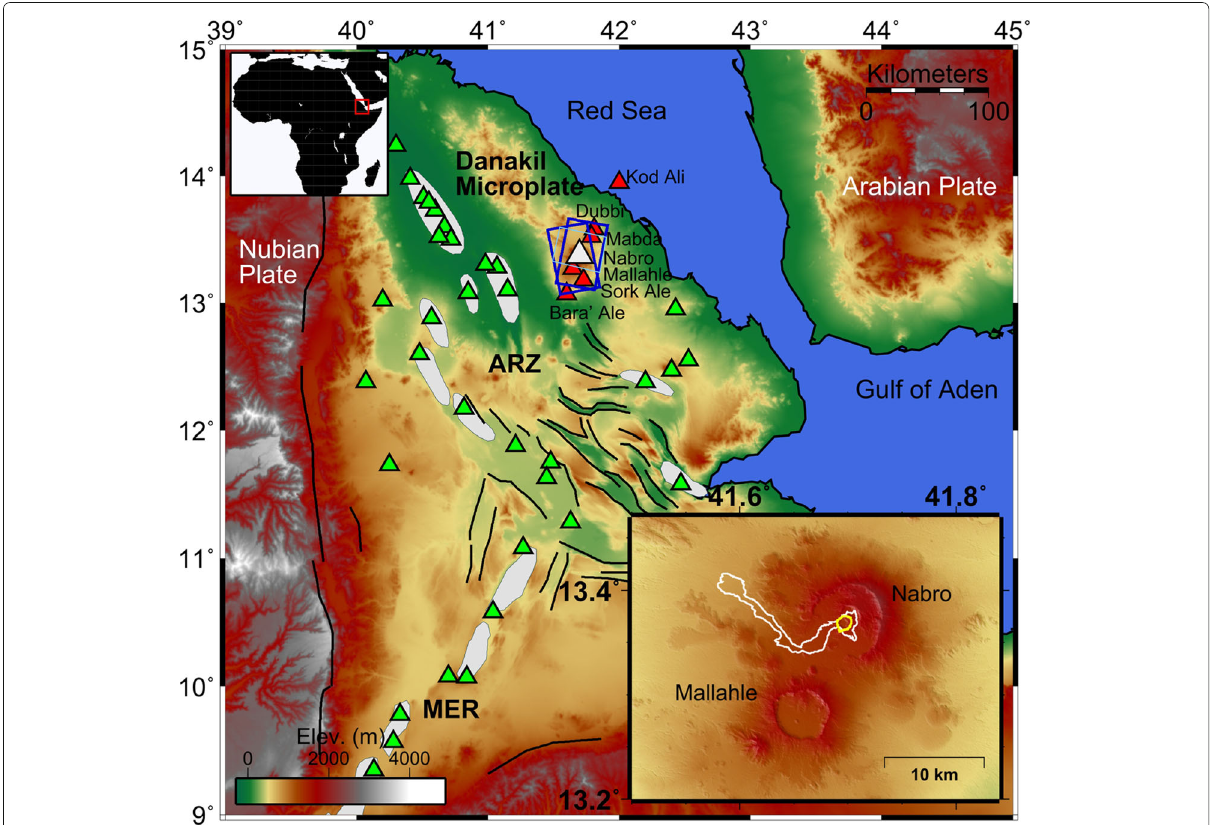
Fig. 1 Topographic map of the Afar Rift Zone (ARZ) from the 90 m SRTM elevation model. Black lines show the regional faults; grey shading shows volcanic segments. Green triangles show positions of volcanoes in the region as defined by the Smithsonian catalogue; red triangles show the volcanoes that comprise the NVR with Nabro highlighted as a white triangle. The footprint of the CSK acquired SAR images is shown in light blue and TSX footprints in dark blue. Upper left inset: the position of the Afar Rift Zone and Main Ethiopian Rift (MER) on the African continent. Lower right inset: topographic map of Nabro and Mallahle volcanoes. The lava flow produced by the 2011 eruption is outlined in white, and the main vent region is outlined in